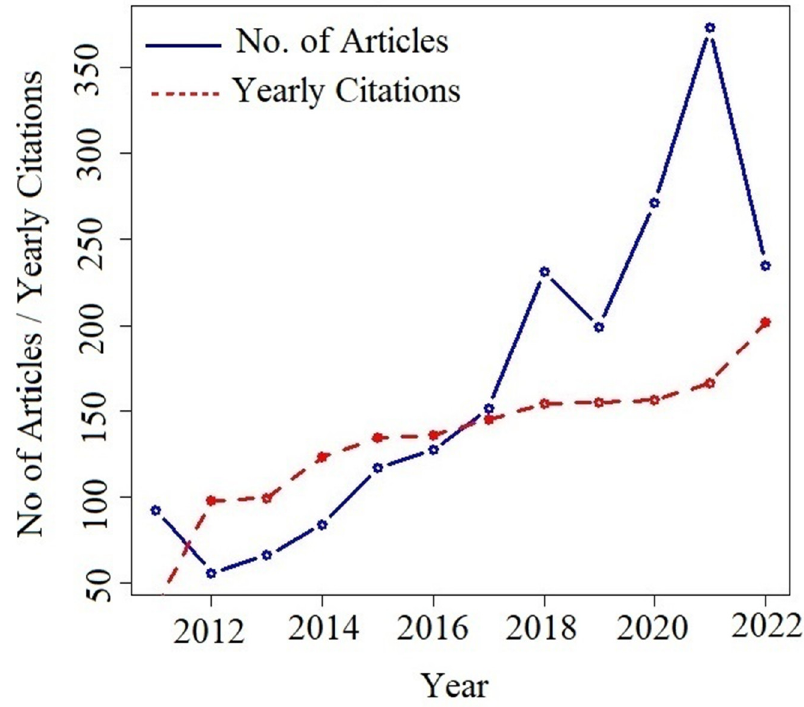
Figure 4. Trend analysis of about publications.